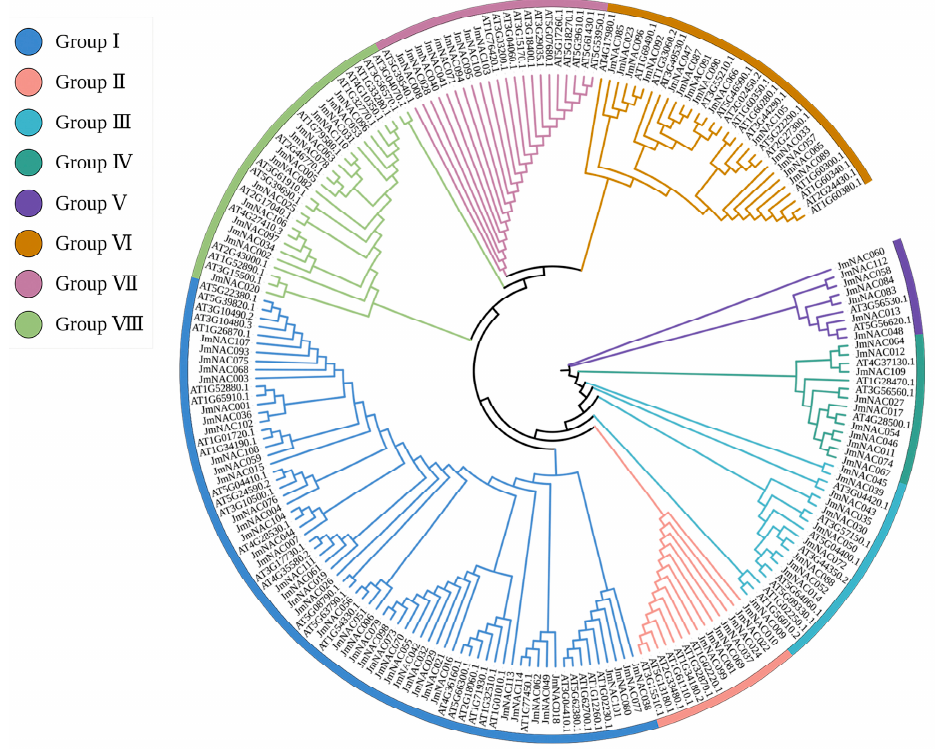
Figure 2. Phylogenetic tree representing the relationship between NAC genes of J. mandshurica and A. thaliana . Different colors represent the subgroups of the NAC gene family in J. mandshurica and A. thaliana .